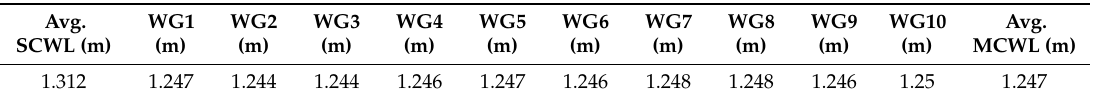
Table 7. Average main channel water level (MCWL), secondary channel water level (SCWL) and WG water level measurements for test 04_B.